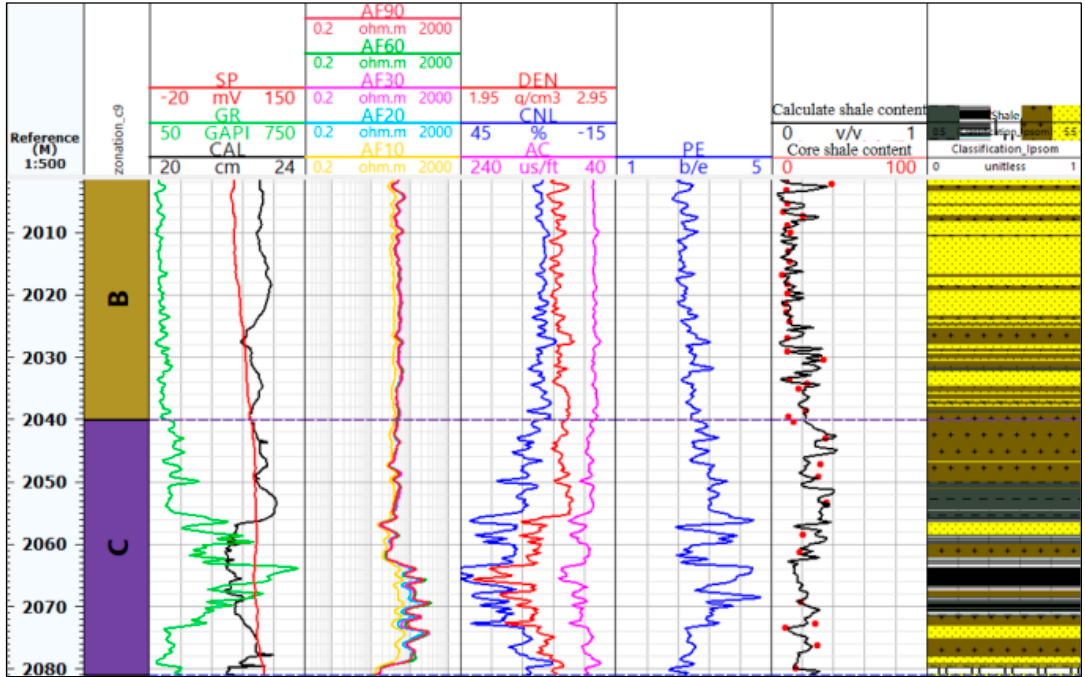
Figure 13. Log interpretation diagram of calculating shale content by combination method in Well J2.